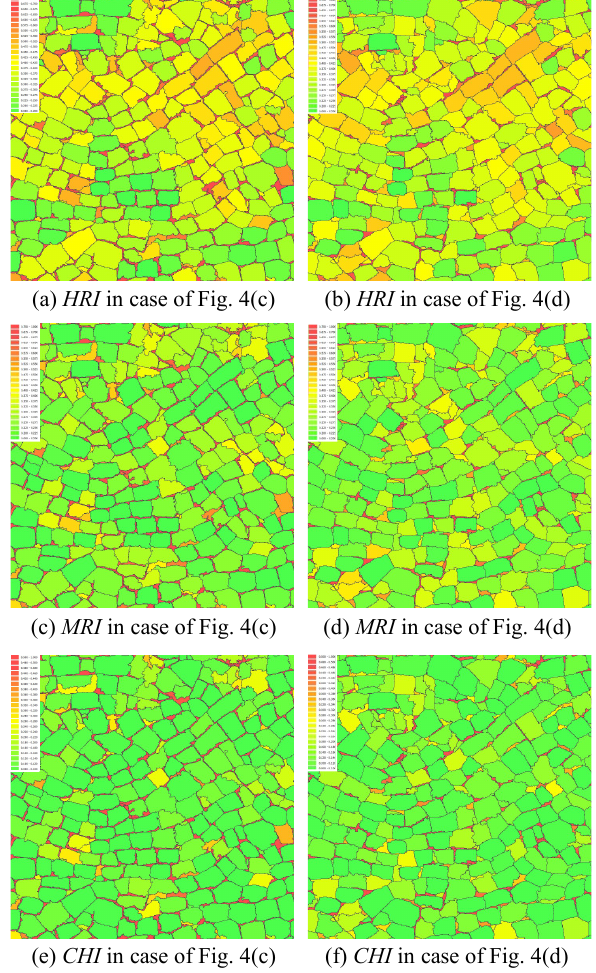
Figure 6. Comparison of irregular-shape indexes for different